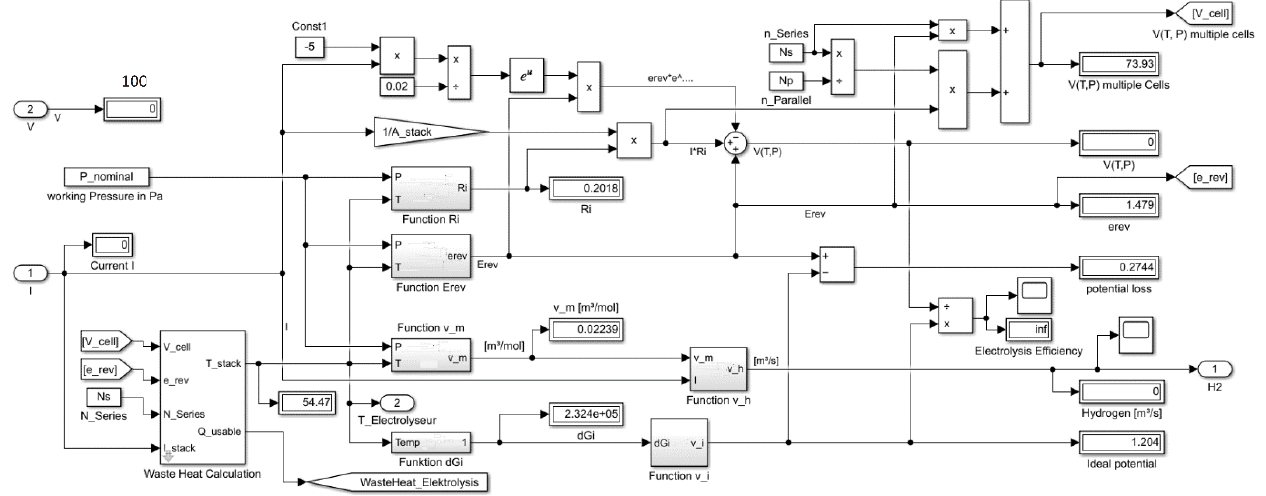
Figure 7. Simulink model of the electrolyser (own figure based on [13,29]).